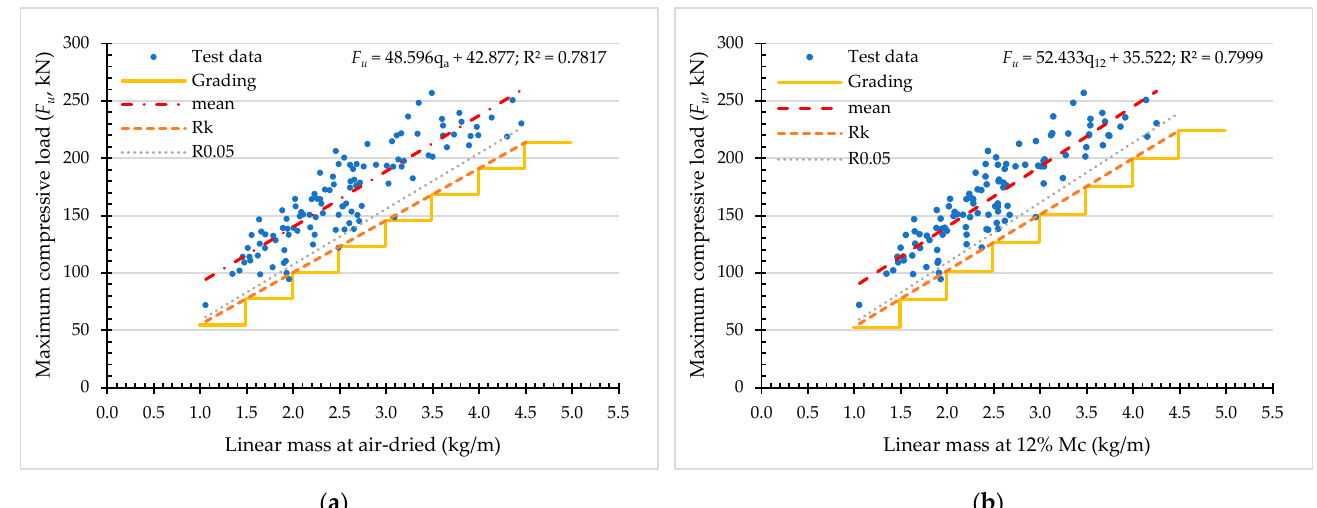
Figure 17. Classification of compressive load of Dendrocalamus sericeus Munro based on air-dried linear mass ( a ) and at 12% M C ( b ). Table 6. Compressive strength grade classification of Dendrocalamus sericeus Munro based on air- dried density and at 12% M C.